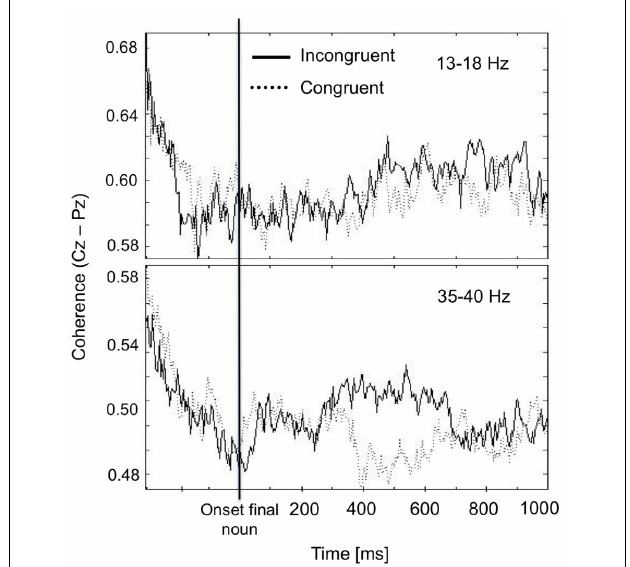
FIGURE 6 | Difference between the coherence during the processing of congruent and incongruent final nouns. The gamma2 frequency band (35–40Hz) shows a higher coherence for the incongruent compared to the congruent sentences from 400 to 600ms after the final noun’s onset. In contrast, the beta1 band does not show this